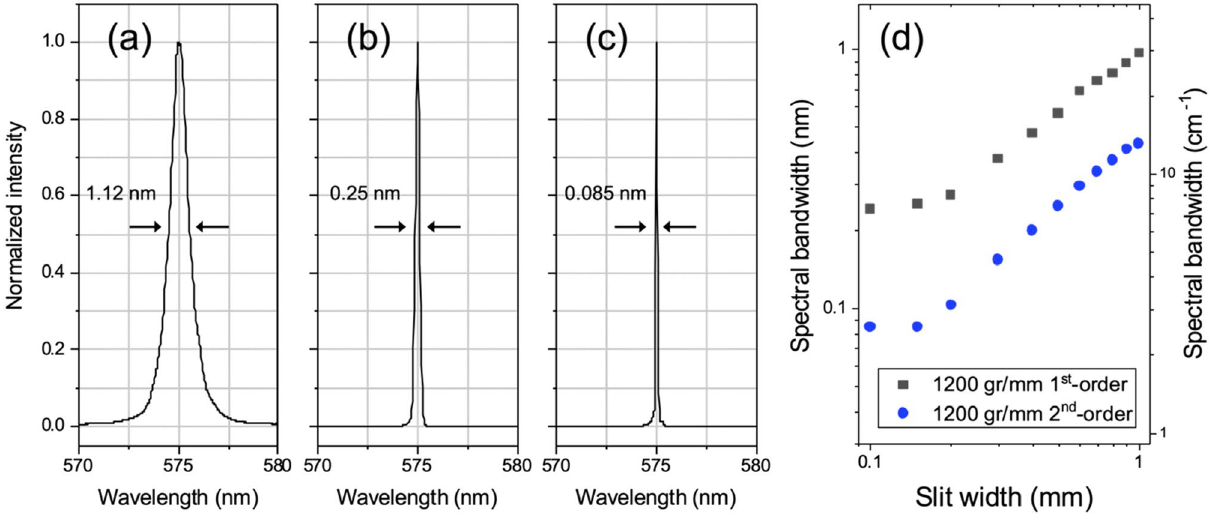
Figure 2. Normalized spectra of Raman-pump pulse for ( a ) the bare output from the ps-OPA, the SHG output from the ( b ) 1st- and ( c ) 2nd-order diffraction DPGF methods at the 0.15 mm slit width. ( d ) Spectral bandwidth fitted by Voigt function depends on the slit width in DPGF using the 1st- and 2nd-order diffraction. The 1800 gr/mm grating (500 nm blaze) was used in the